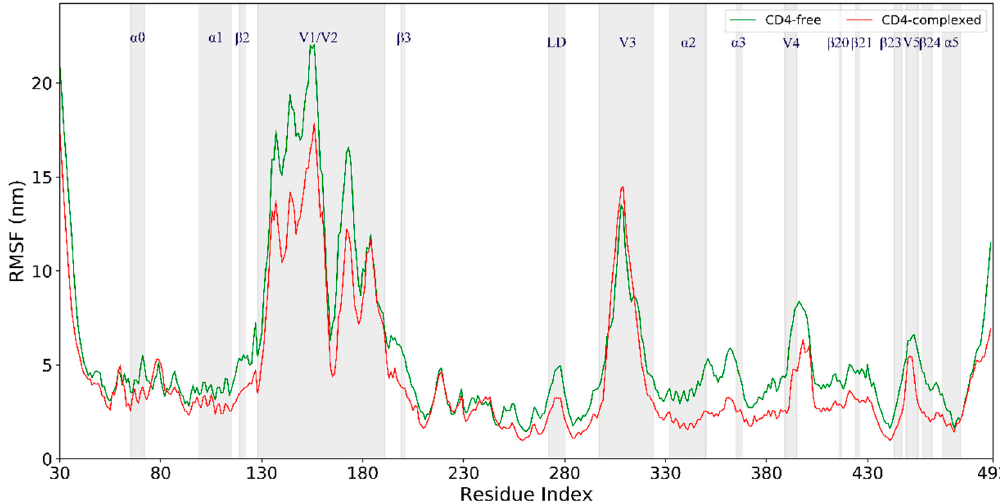
Figure 3. Root-mean-square fluctuation (RMSF) values of the C α atom as a function of the residue number for the CD4-free (green line) and CD4-complexed (red line) gp120s.